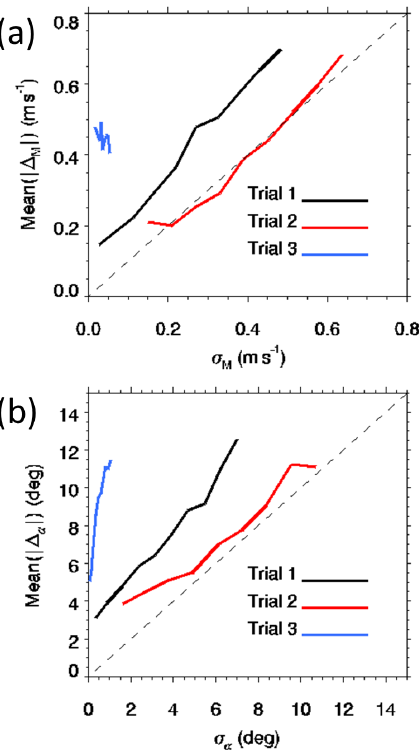
Figure 7. (a) Mean absolute difference in wind speed between the CDL and the BAO tower sonic anemometers as a function of the es- timated wind speed precision, σ M . (b) Mean absolute difference in wind direction between the CDL and tower as a function of the esti- mated wind direction precision, σ α . The black, red and blue curves show the results for trials 1, 2 and 3, respectively.